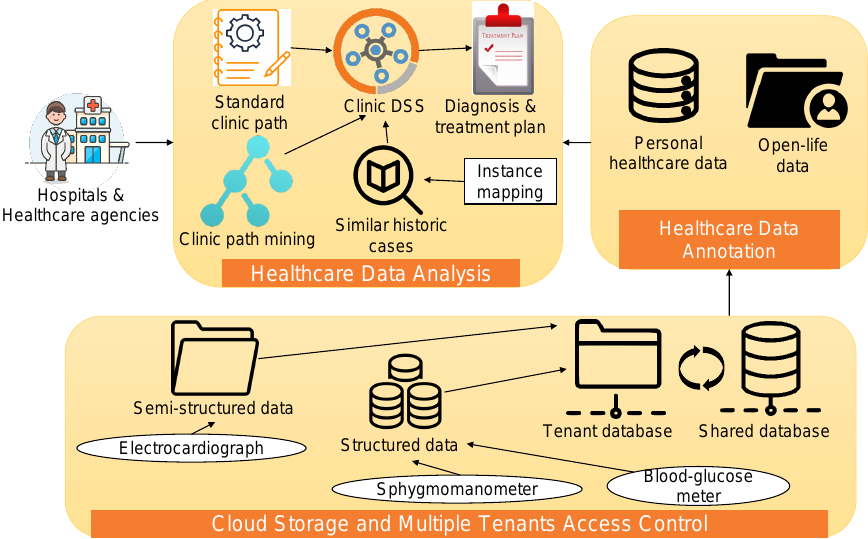
Figure 7. Functional platform of the cloud-computing-based m-Health monitoring system with three main layers’ cloud storage and multiple tenants access control, healthcare data annotation, and healthcare data